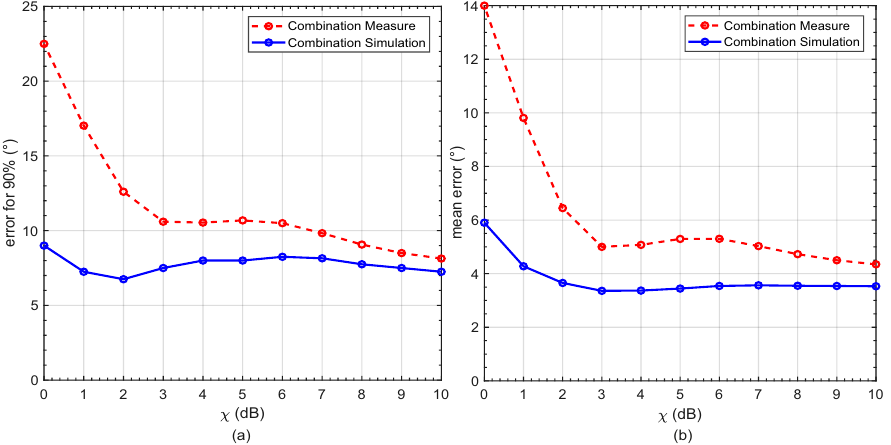
Figure 19. Comparison for D = 3 m between measurement and simulation environment of 90-th percentile combined DoA estimation error ( a ) and Mean combined DoA estimation error ( b